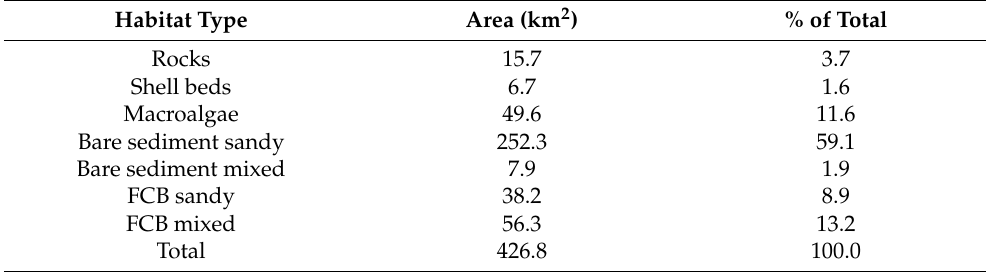
Figure 6. Detailed view on an example area for sandy and mixed sediments within bare sediment and fiddler crab burrow (FCB) areas, with visual comparison to an equivalent RGB image (with linear colour stretch) produced from the same Sentinel-2 image for which predictions were conducted to produce the final map. Maps of the three most important predictors to classify these habitat types are shown for the same area (DEM, nNDMI, and S1-VH). Colours for DEM and nNDMI range from blue for lowest, yellow for intermediate, and orange-red for highest values. S1-VH are represented in grey-scale values. Dark blue areas represent the water mask, light grey areas represent the land mask (excluding mangroves), and dark grey areas represent mangroves. ( A ) Aerial photograph of the example area, showing the striking visual difference between bare sediment and FCB habitats; ( B , C ) show photographs of on the ground examples of bare sediment and FCB habitats, respectively. Table 5. Estimates of the total area (in km 2 and in % of the total) covered by each intertidal habitat, produced from the final map predictions with the final model (14 predictors). FCB: fiddler crab burrow